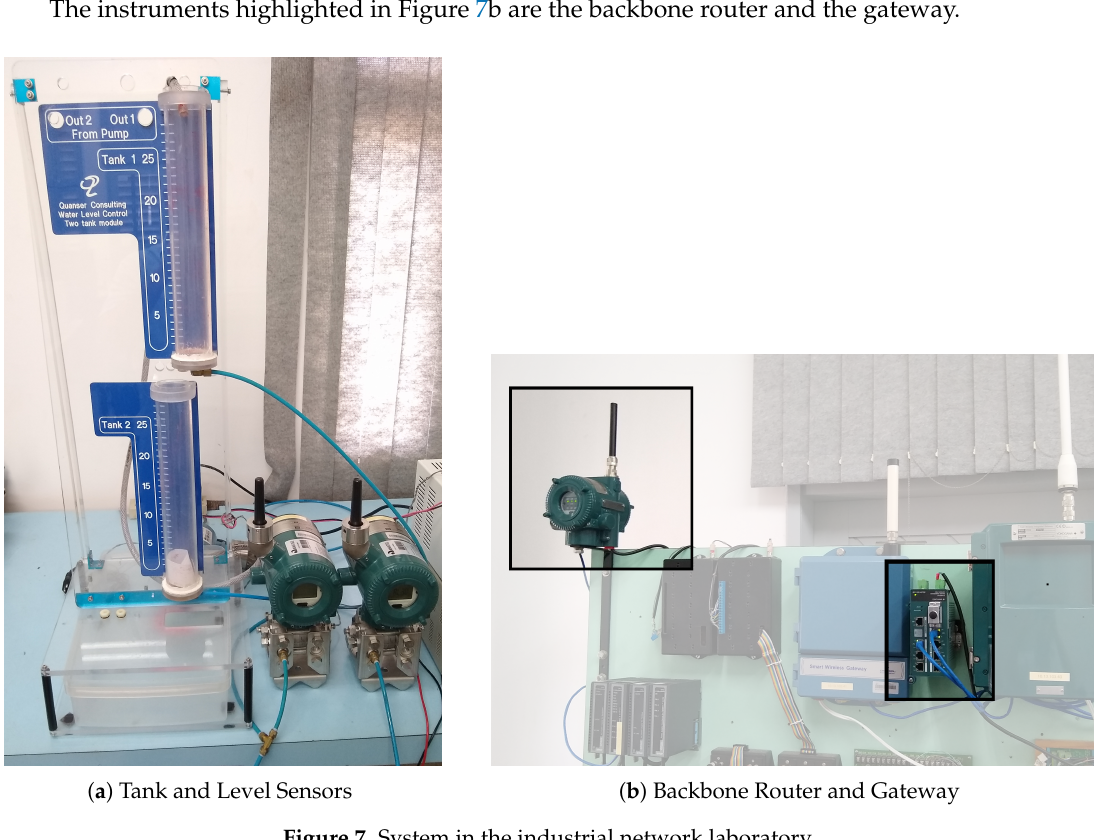
Figure 7. System in the industrial network